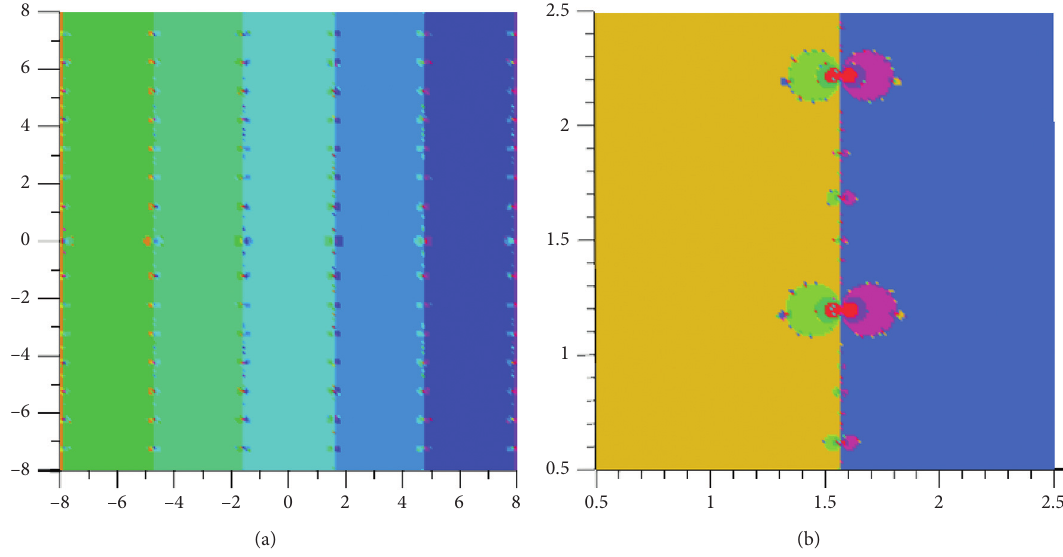
( z ) at z � π /2 + iy . s